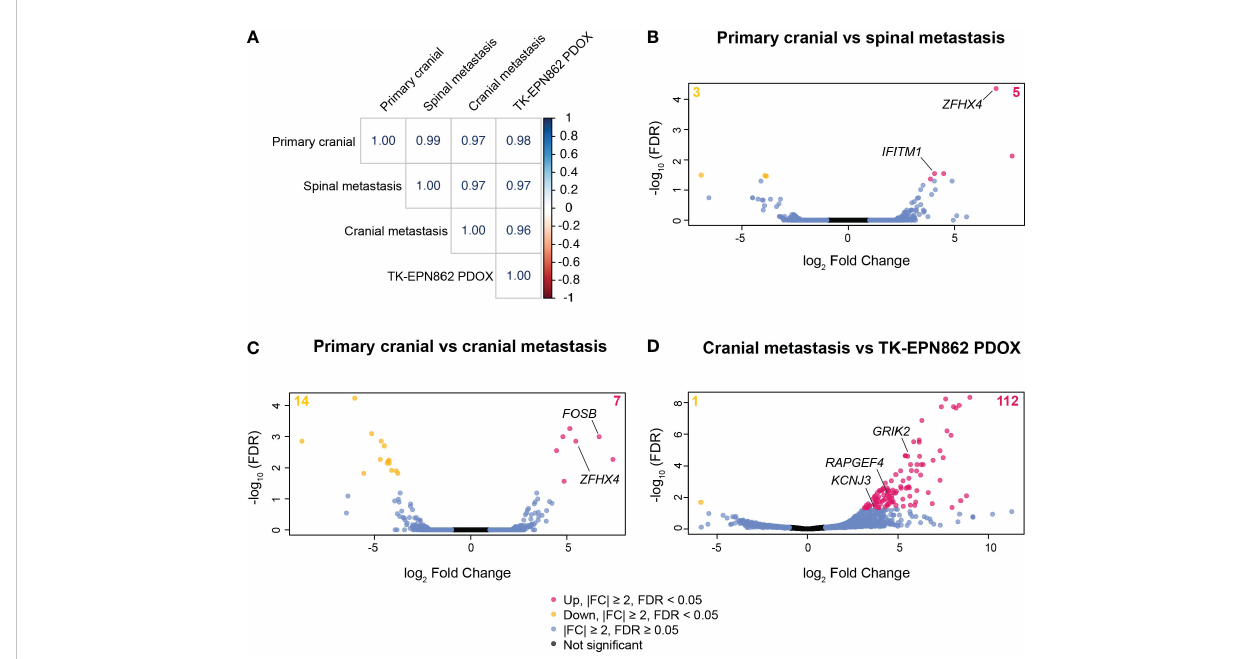
FIGURE 8 Gene expression patterns are highly conserved between the primary tumor, spinal metastasis, cranial recurrent lesion and the TK-EPN862 PDOX model. (A) Correlation matrix showing the correlation coef fi cient values for each sample comparison shown. (B – D) Volcano plots depicting differentially expressed genes between the samples stated on each plot. Pink dots and yellow dots represent genes that are statistically signi fi cantly over- or under-expressed, respectively, between the samples described (|FC| ≥ 2 and FDR < 0.05), blue dots represent genes that have |FC| ≥ 2 and FDR ≥ 0.05, and black dots represent genes that are not signi fi cantly differentially expressed (|FC| ≤ 2 and FDR ≥